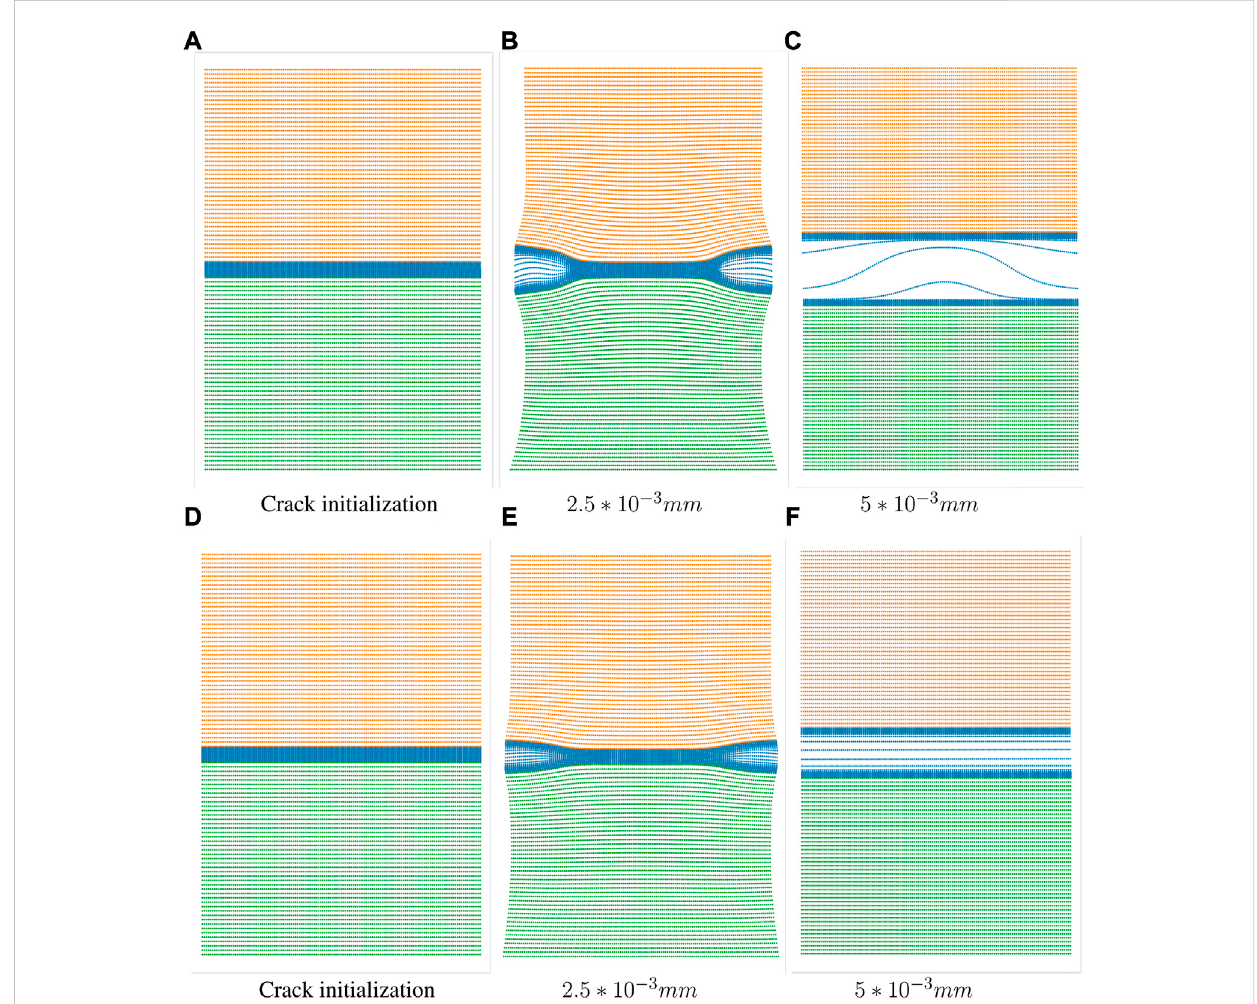
FIGURE 13 Scatter plots of Symmetric double notched plates with 4 and 10 times of model enlargement while maintaining the peak stress unchanged. The upper half: